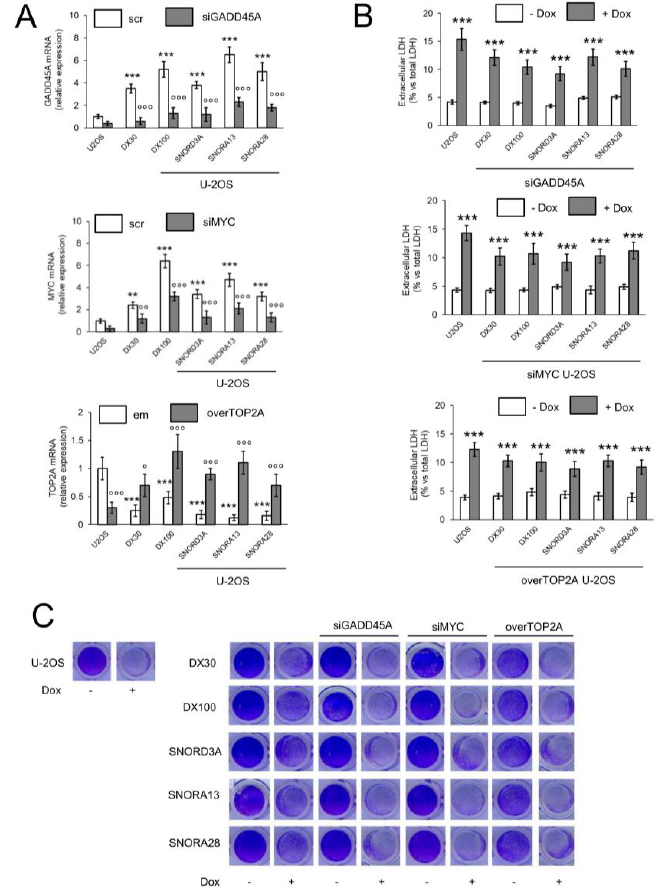
Figure 5. GADD45A , MYC and TOP2A are responsible for the doxorubicin resistance induced by SNORD3A , SNORA13 and SNORA28 . U-2OS cells were transfected with an expression vector for SNORD3A , SNORA13 or SNORA28